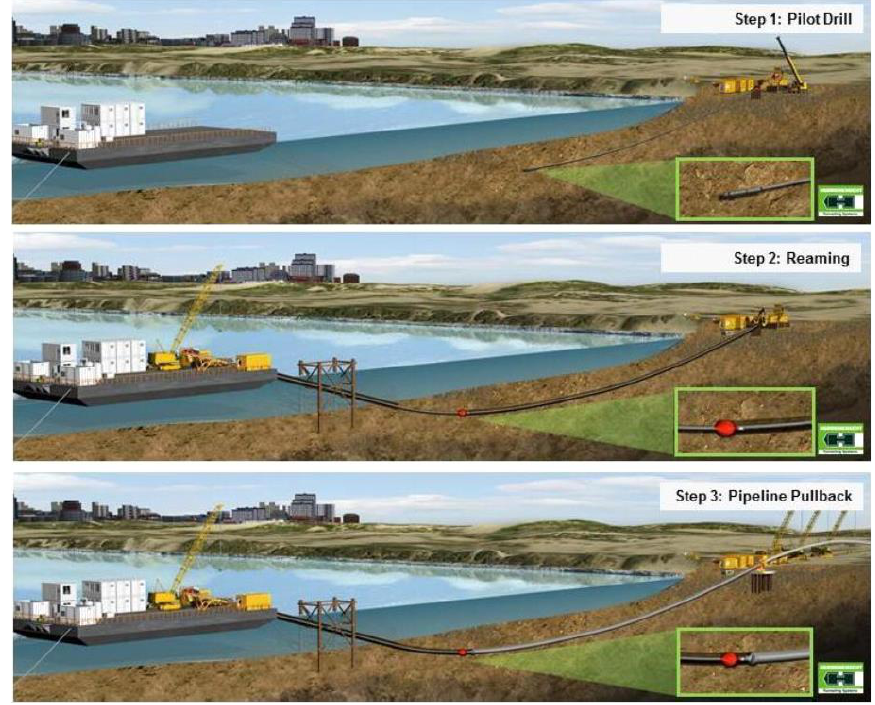
Figure 3. HDD drilling scheme for land – sea transition. Source: Herrenknecht.